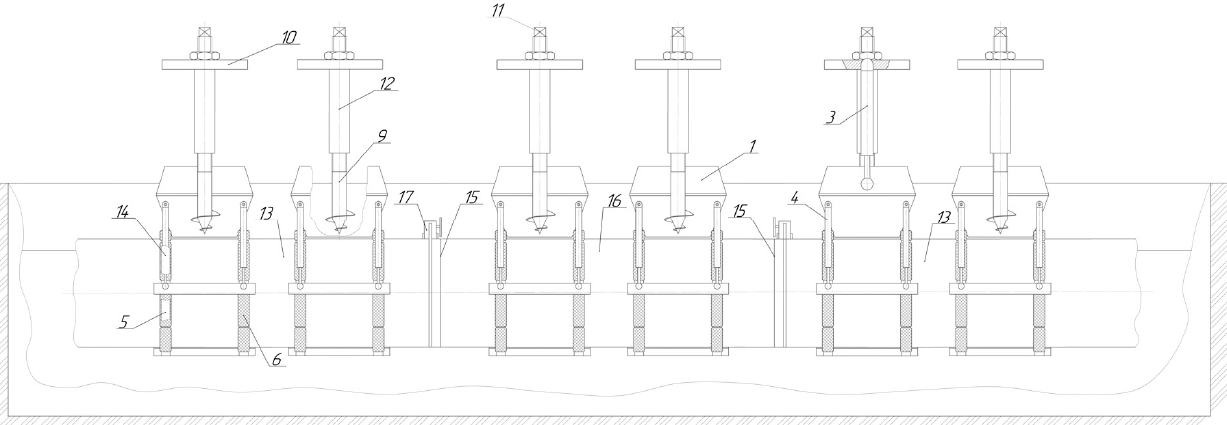
Figure 4. Side view of the device in the process of centering the pipeline after cutting out the defec-